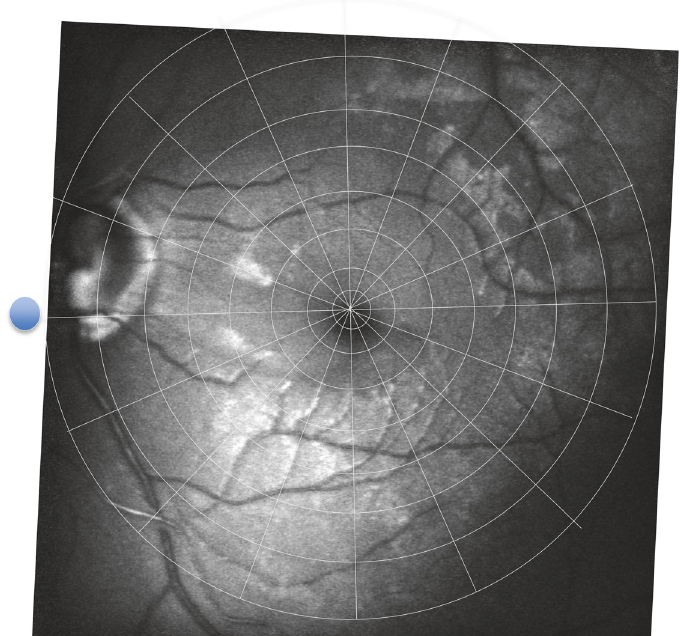
Figure 3: Red-free fundus photography with superimposed visual fi eld pattern showing the presence (ARAM+) or absence (ARAM − ) of ARAM at each testing point.